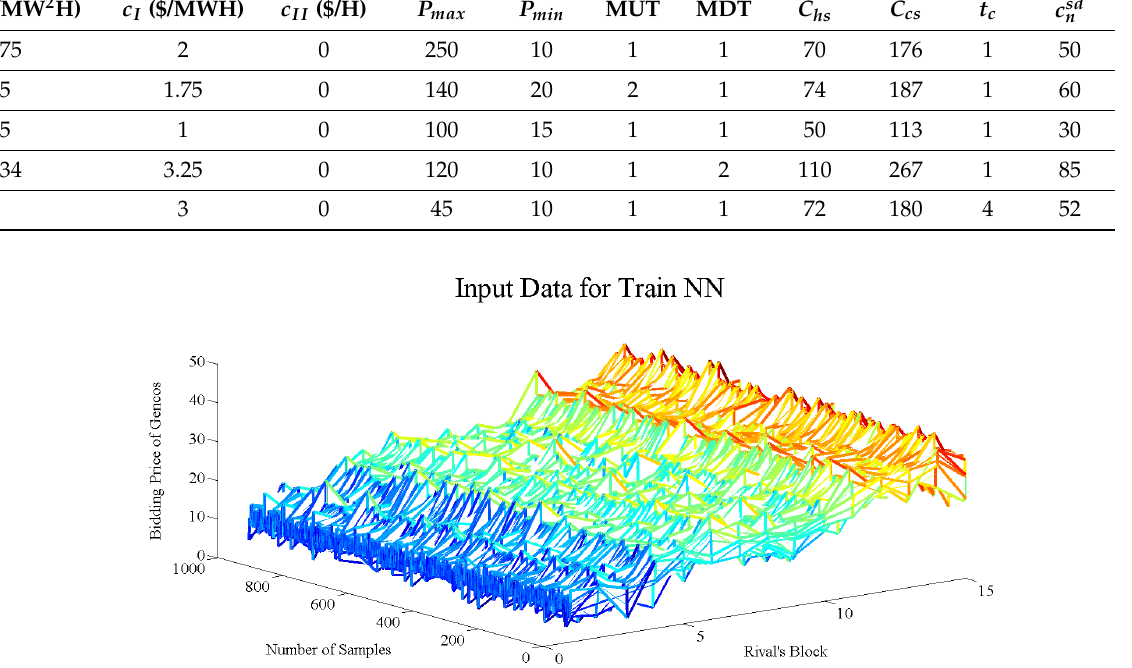
Figure 13. Input data for training the Neural